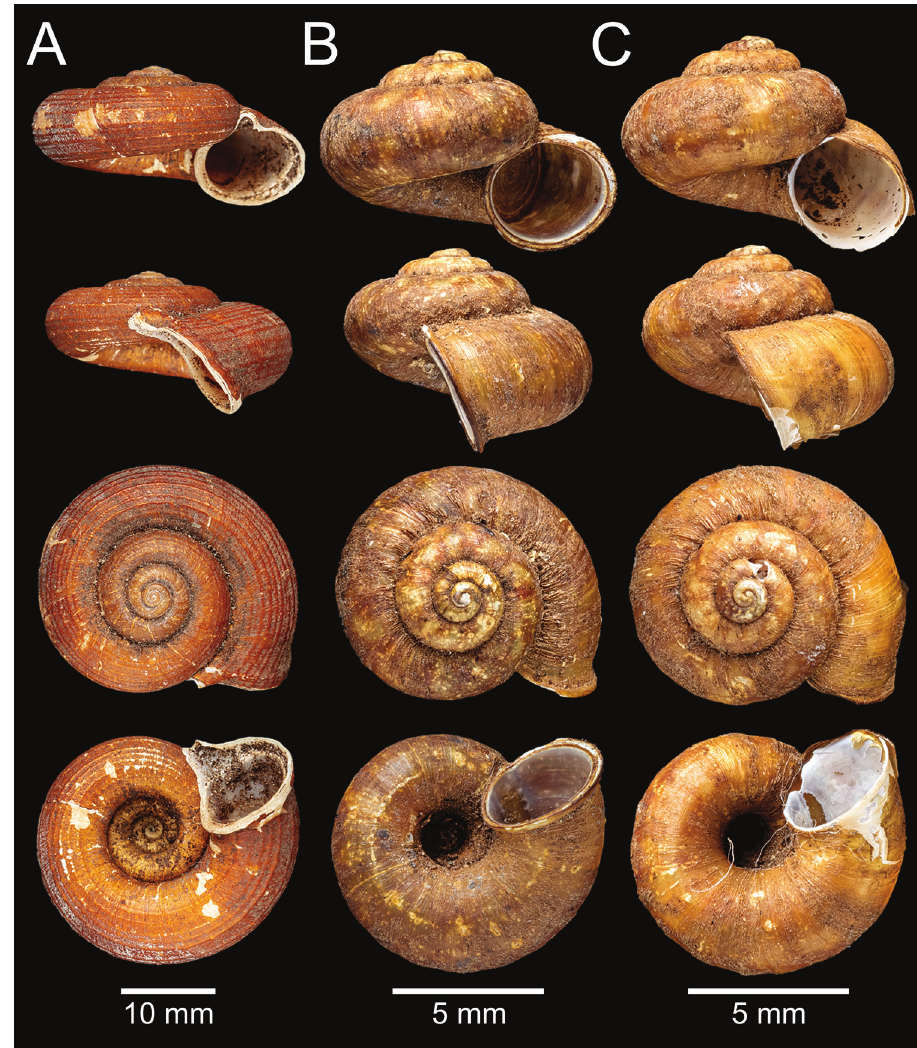
Figure 8. A lectotype of Pterocyclos miriensis , NHMUK 1903.7.1.3580/1 B, C Theobaldius oakesi : B lec- totype NHMUK 1903.7.1.3083/1 and C paralectotype NHMUK